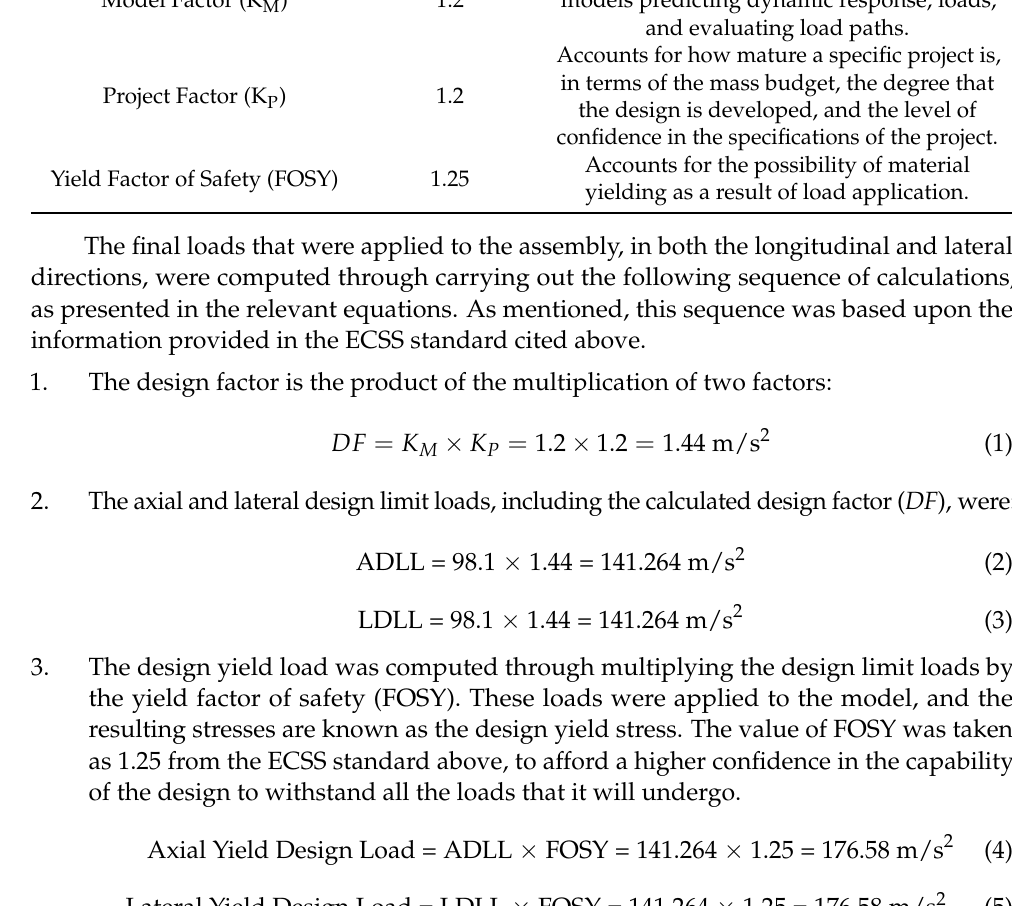
Table 1. Factors related to dynamic launch loads. Factor Value Description Accounts for uncertainties in mathematical models predicting dynamic response,